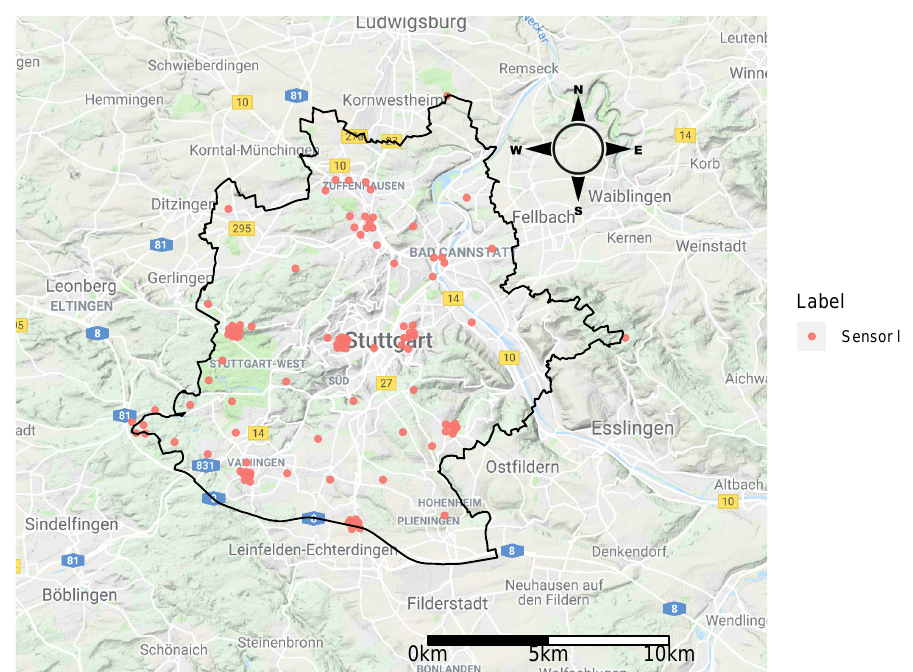
Figure A3. Optimal locations considering prediction error and wide-spread aspect in the objective function for Stuttgart LUR model developed using low-cost sensor network